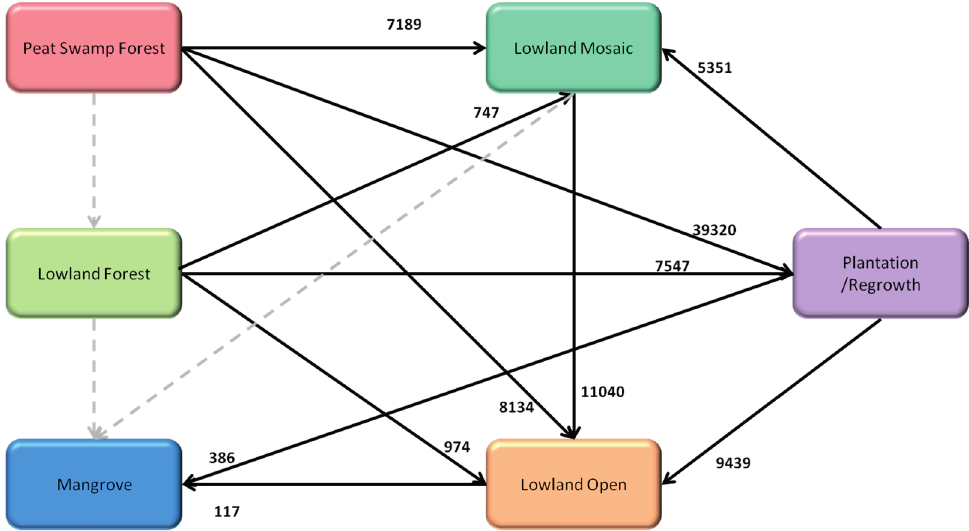
Figure 5. Net land cover transitions in hectares (only showing transitions >100 ha) over 30-year projection. Data from Table 7 rounded to nearest 100 ha. Minor transitions shown by grey dashed